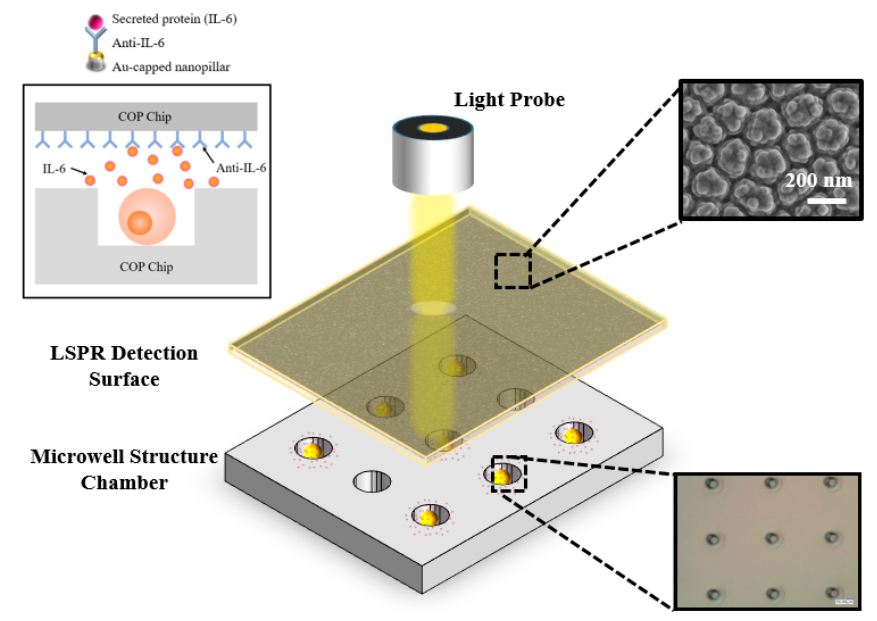
Figure 1. Schematic of the integrated localized surface plasmon resonance (LSPR) cytokine detection platform device.